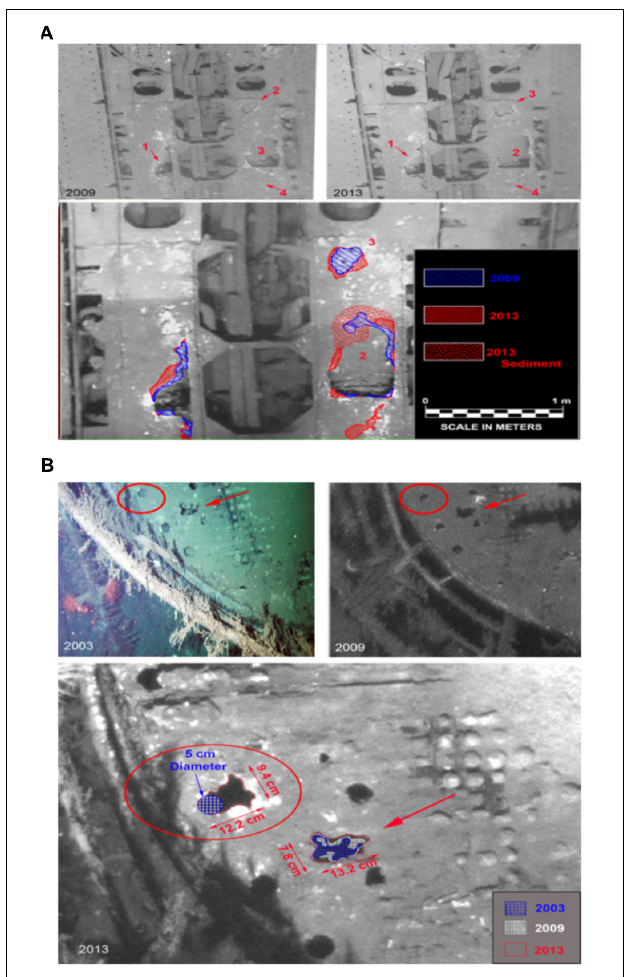
FIGURE 7 | Metal deterioration on the deck of the U-166 . (A) Deterioration in U-166 ’s aft deck from 2003, 2009, and 2013. (Upper) 2009 and 2013 image showing section of the deck, and (Lower) 2003 photo with 2009 (Blue) and 2013 (Red) shown as hatched overlay. (B) Deterioration on the deck of U-166 ’s conning tower. (Upper) 2003 and 2009 images, and (Lower) prior images shown as hatched overlay of 2013 image.